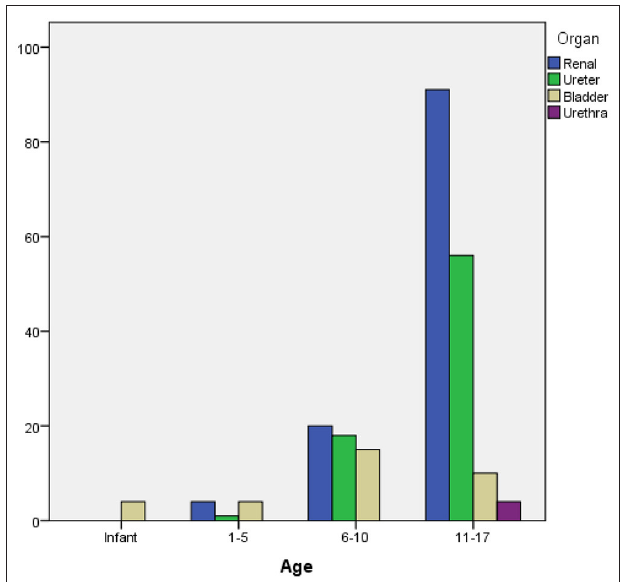
FIGURE 1 | Distribution of stone locations based on age groups.